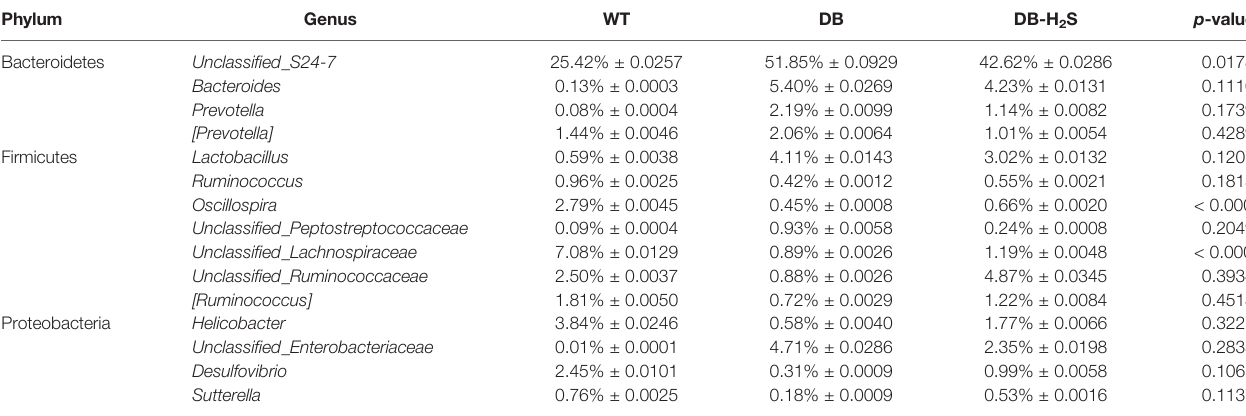
TABLE 1 | The relative abundance of bacterial genera that showed an improvement by treatment with exogenous